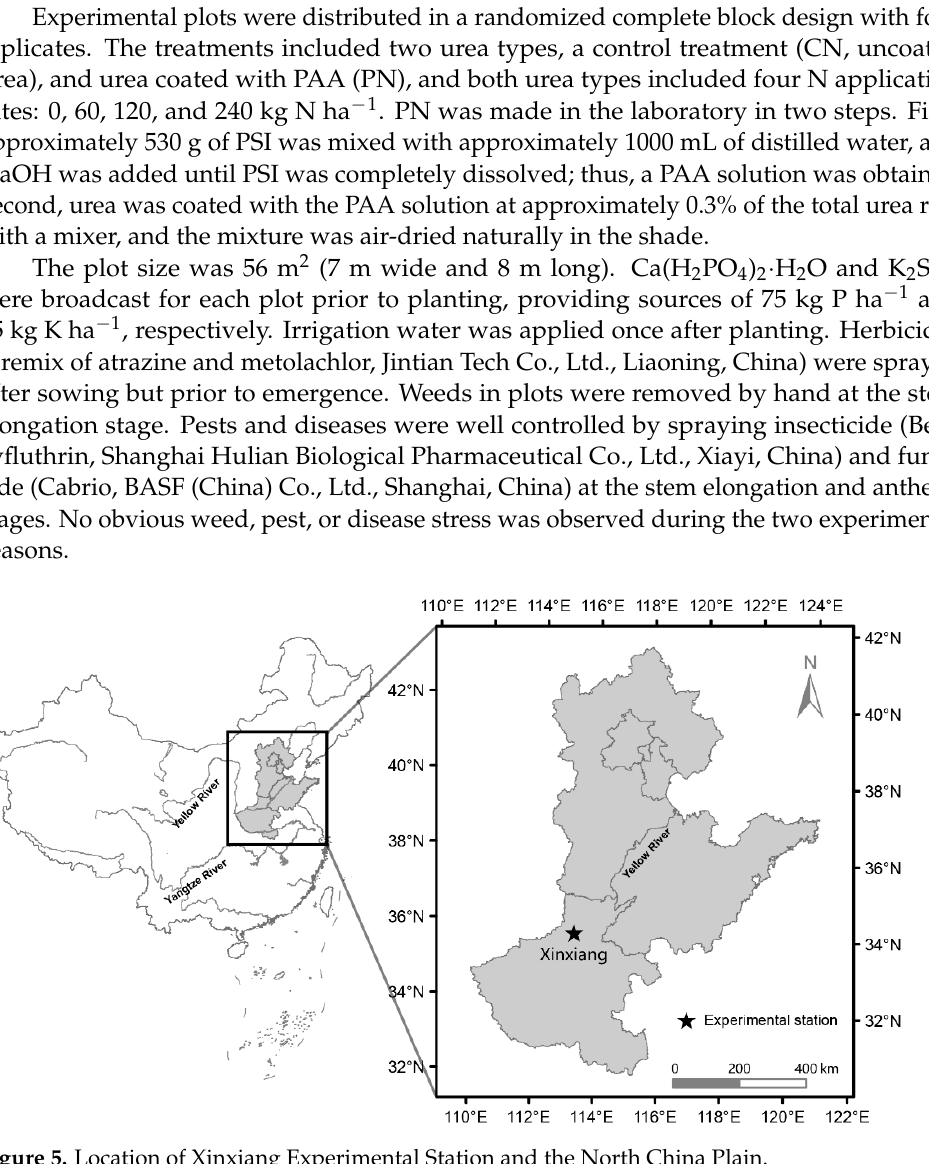
Ammonium Available Available N P K